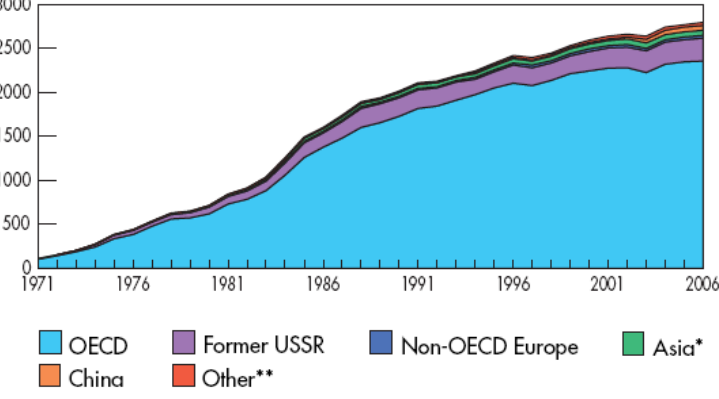
Figure 16. Evolution of nuclear electricity production (TWh/year) by region. Asia excludes China, and “Other” includes Africa, Latin America and the Middle East. © 2008 OECD/IEA, reproduced from [17] with permission.